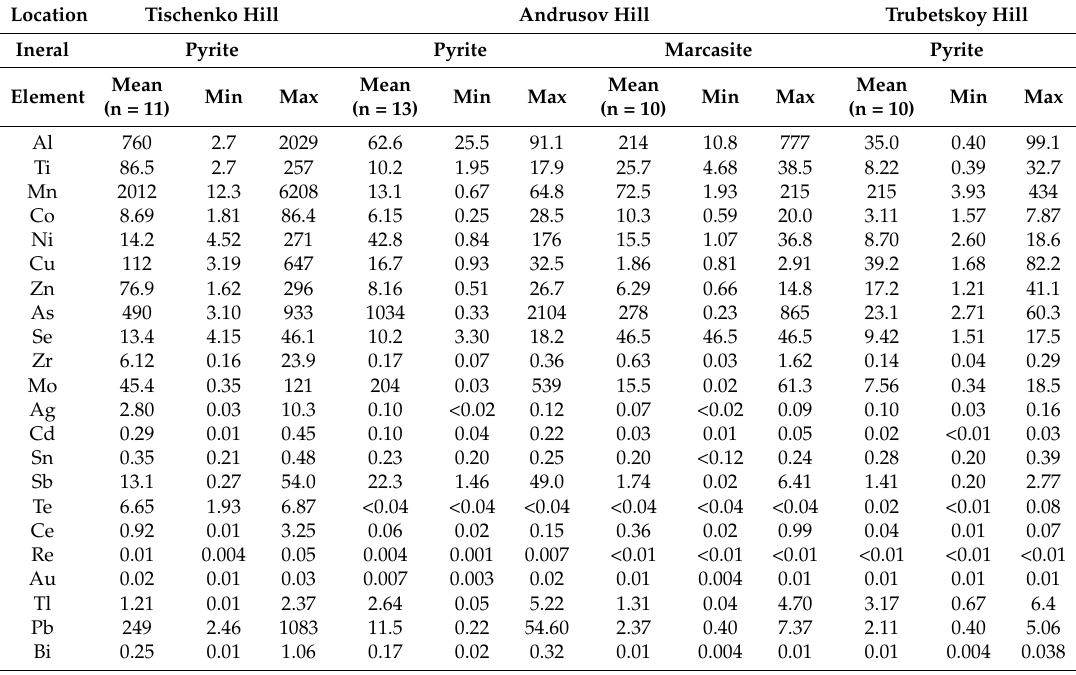
Table 8. Trace element composition of pyrite and marcasite crystals from mud masses, Bulganak MV area, Kerch-Taman MV province. LA-ICPMS data,